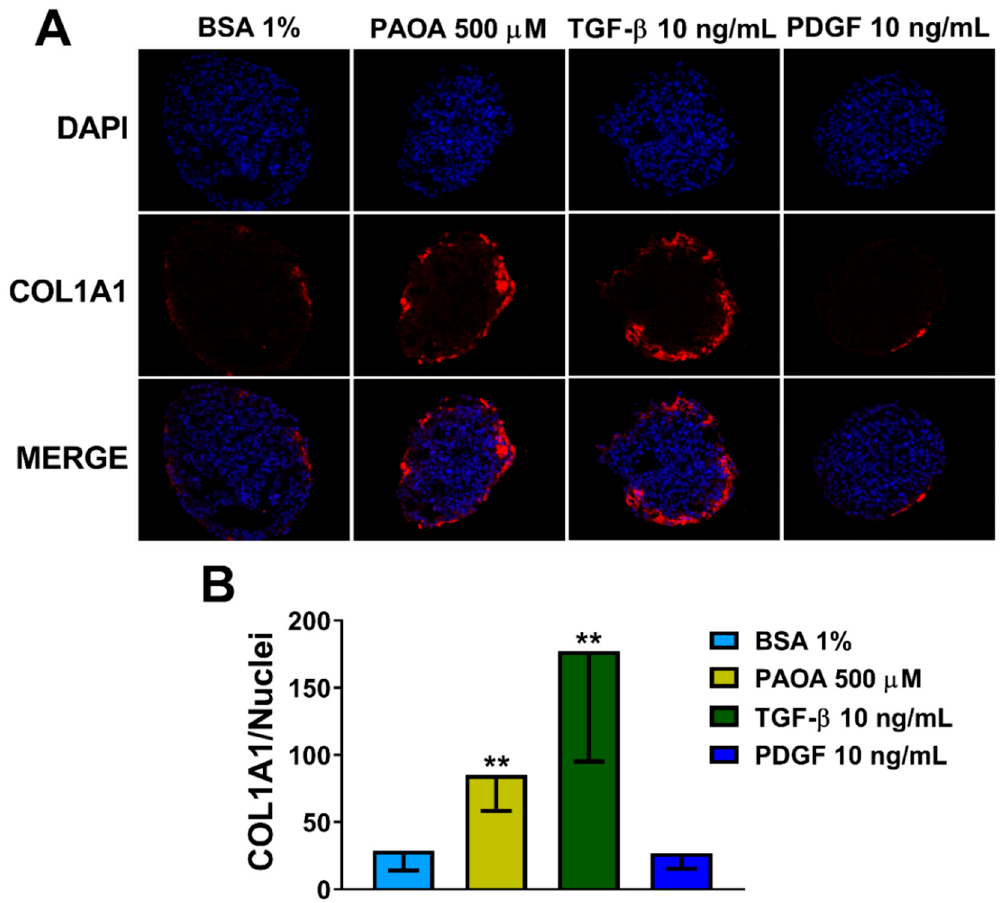
Figure 4 . Fatty acid treatment results in an increase in COL1A1 levels in 3D multilineage spheroids . ( A ) Immunofluorescence staining of DAPI (blue), COL1A1 (red) and merged images of 3D